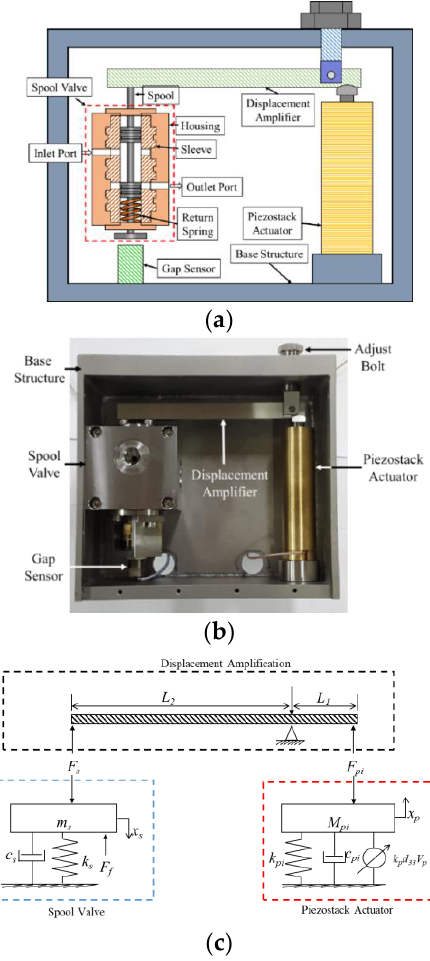
Figure 2. The proposed piezostack actuator direct-drive valve (PADDV) system. ( a ) Schematic configuration of PADDV, ( b ) Photograph image of the manufactured PADDV, ( c ) Mechanical model of proposed PADDV.